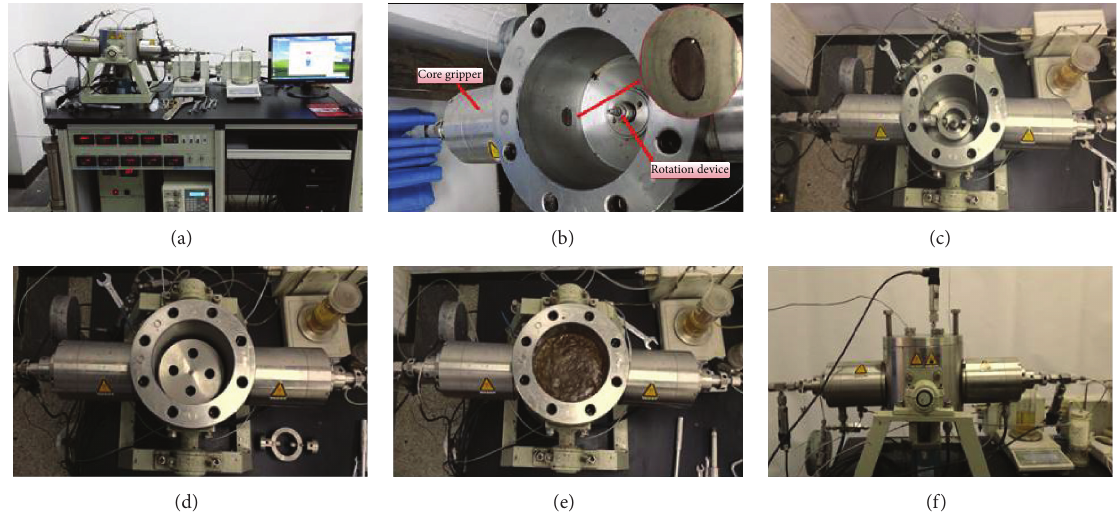
Figure 10: Dynamic damage tester: (a) full view of tester; (b) core in gripper; (c) core displacement process; (d) internal rotation device; (e) joining drilling fluid and rotating (another drilling fluid); (f) sealing and inflating to simulate wellbore conditions.